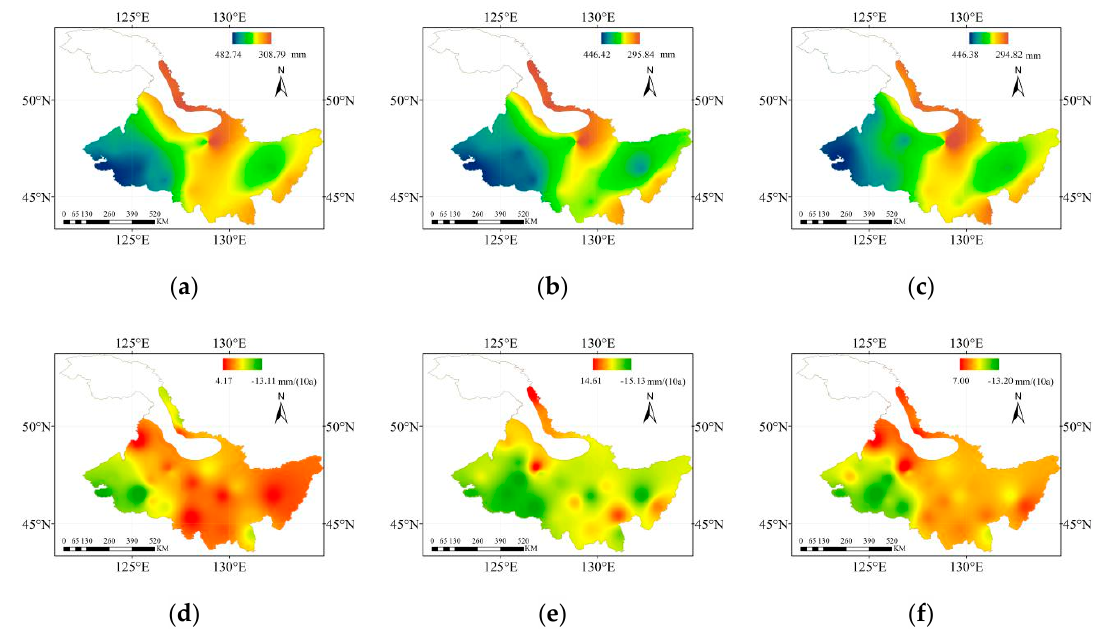
Figure 3. Average crop water requirement ( ET c ) during ( a ) 1960–1979, ( b ) 1980–1999, and ( c ) 2000–